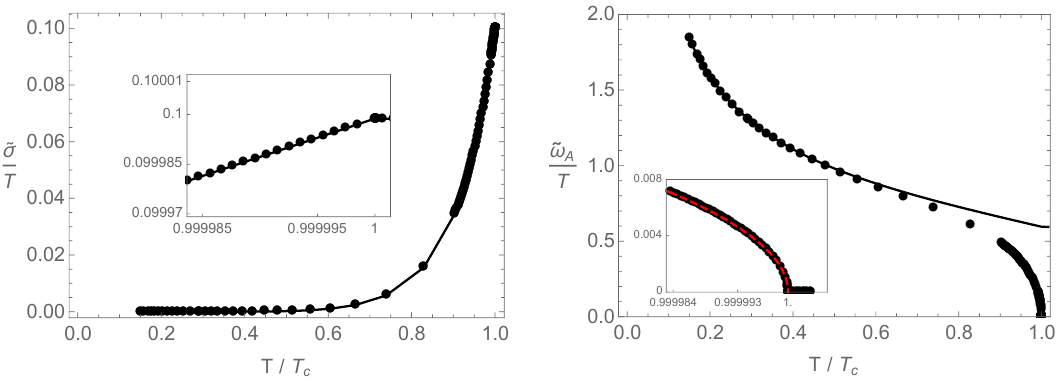
Figure 7 . The temperature dependence of the phenomenological paramters ˜ σ and ˜ ω A in eq. (5.4). Dots are evaluated from the numerical fits. Solid lines represent the analytical expression in eq. (5.9) (left panel) and eq. (5.11) (right panel). The insets show the data near the critical point, T = T The dashed red line in the right panel is the expression in eq.